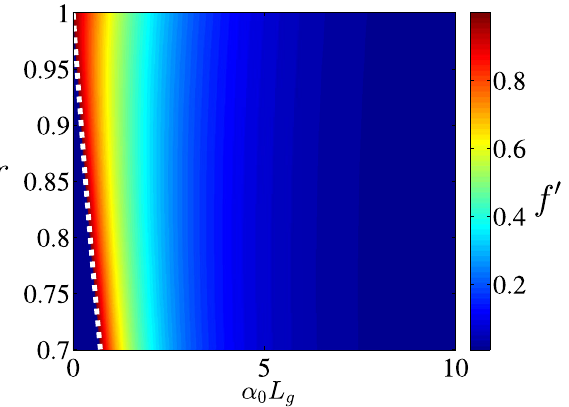
Figure 5. Derivative f ′ (� ∗ ) for the non-trivial steady-state solution (cid:31) ∗ of Eq. (12), describing its stability, vs. parameters r and α 0 L g . White dashed line shows the boundary between domains Eqs. (16) and (17), i.e. to the left of this boundary non-trivial solution (cid:31) ∗ does not exist. This figure was created with Matlab R2018a (http:// www.mathw